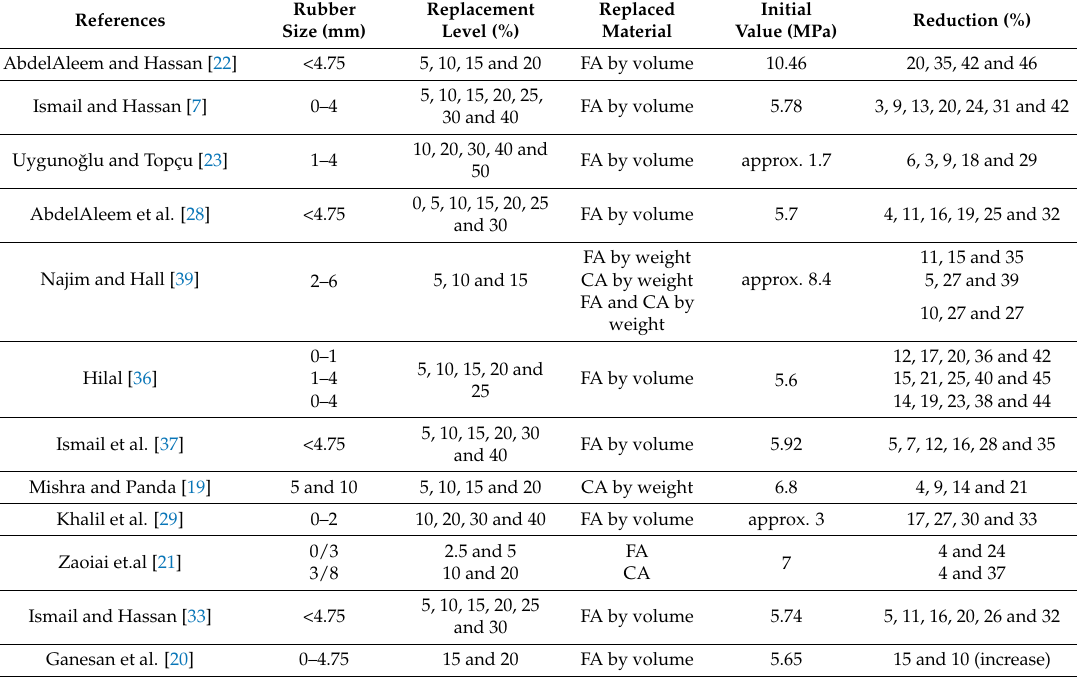
Table 4. Influence of rubber size, replacement level and replaced material on 28-days flexural strength of